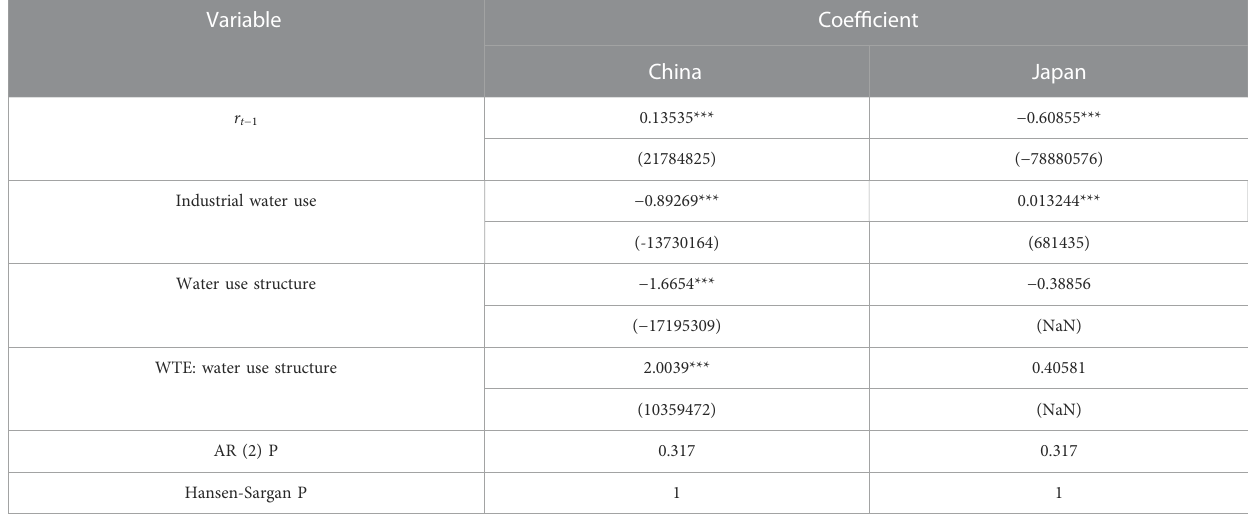
TABLE 8 Role of technology in the mechanism of water use structure affecting stock market returnsn.